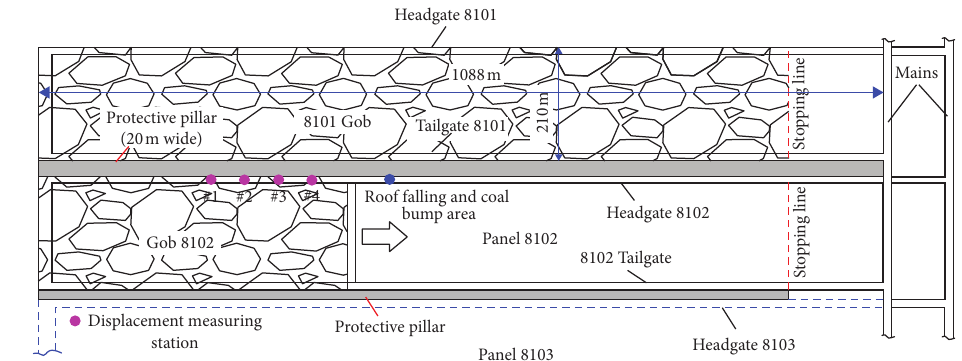
Figure 3: Layout of roadway and panel at the test site.